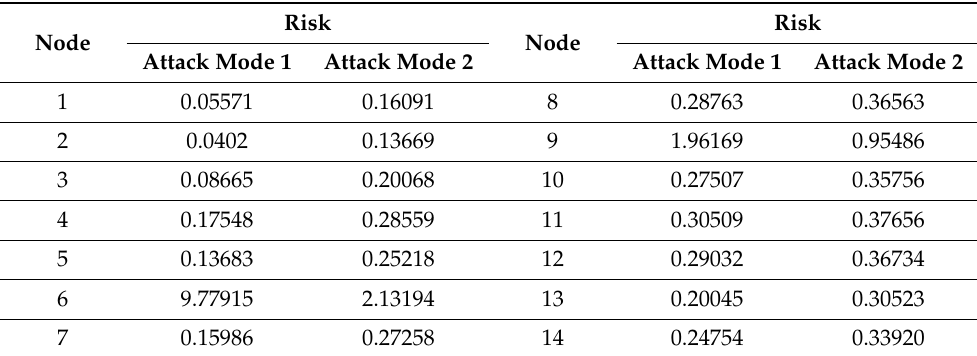
Table 1. Node risk under different attack modes.